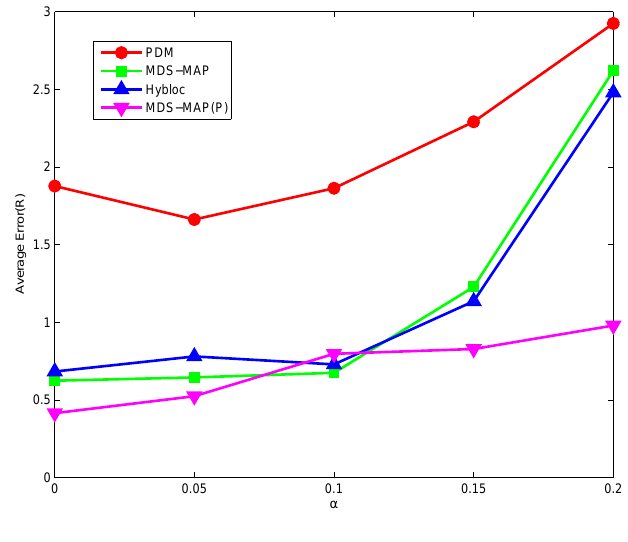
Figure 12 . 5 Clustered Anchors, Average Connectivity=10.74, Uniform